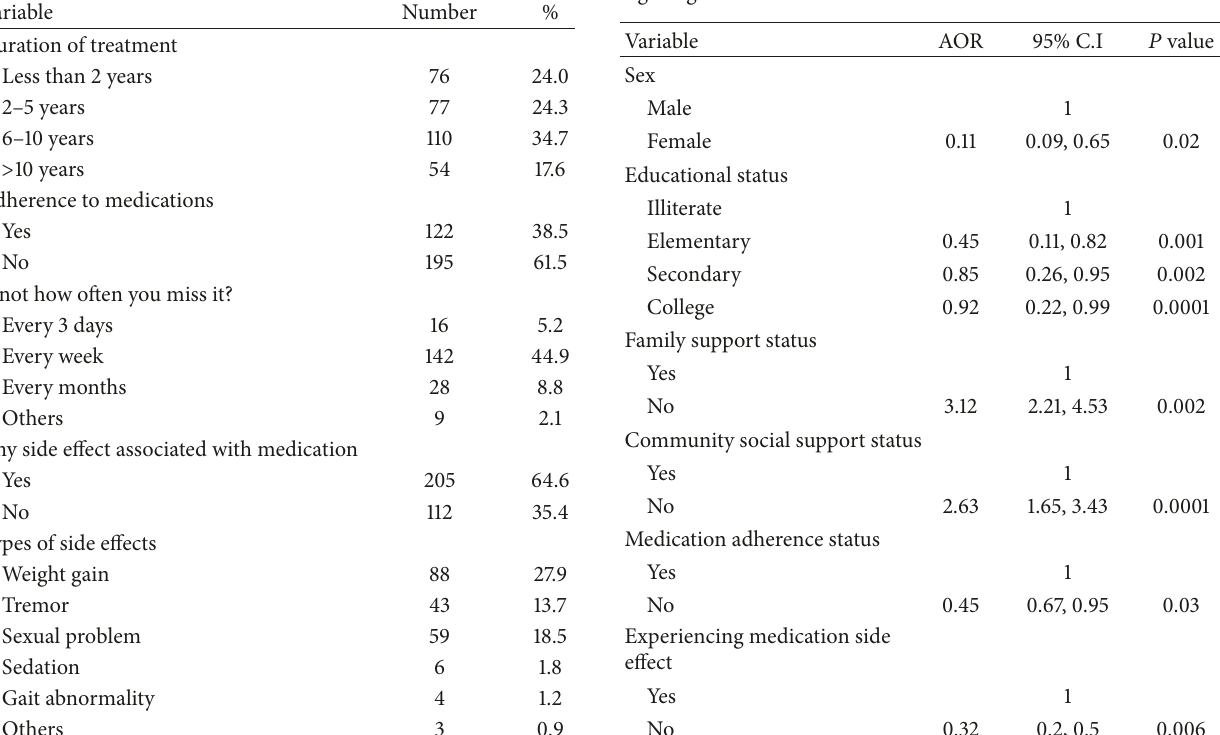
Table 3: Clinical characteristics of participants. Table 4: Multivariate logistic regression; factors associated with high stigma